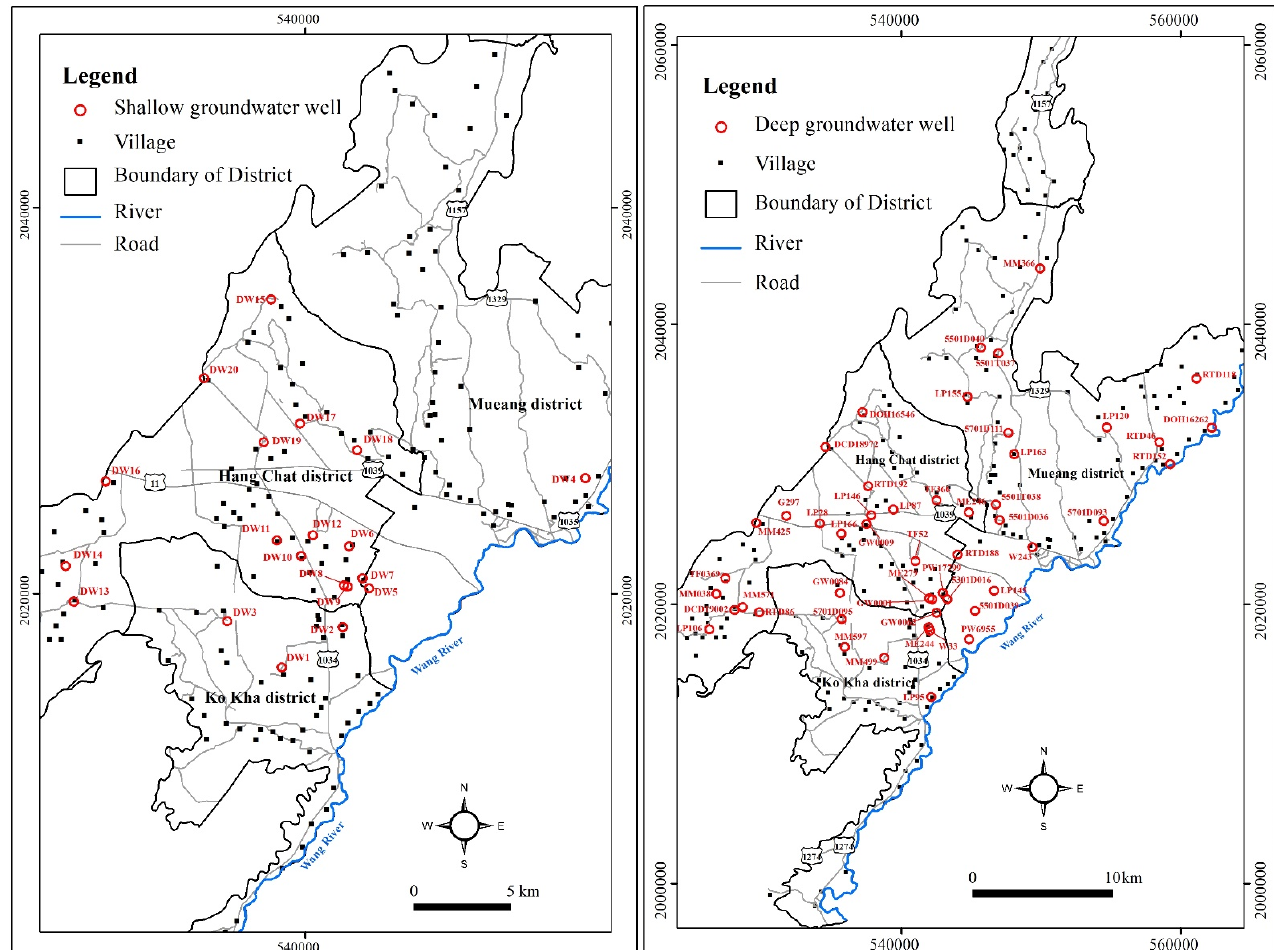
Figure 3. Locations of shallow ( left ) and deep groundwater wells ( right ).